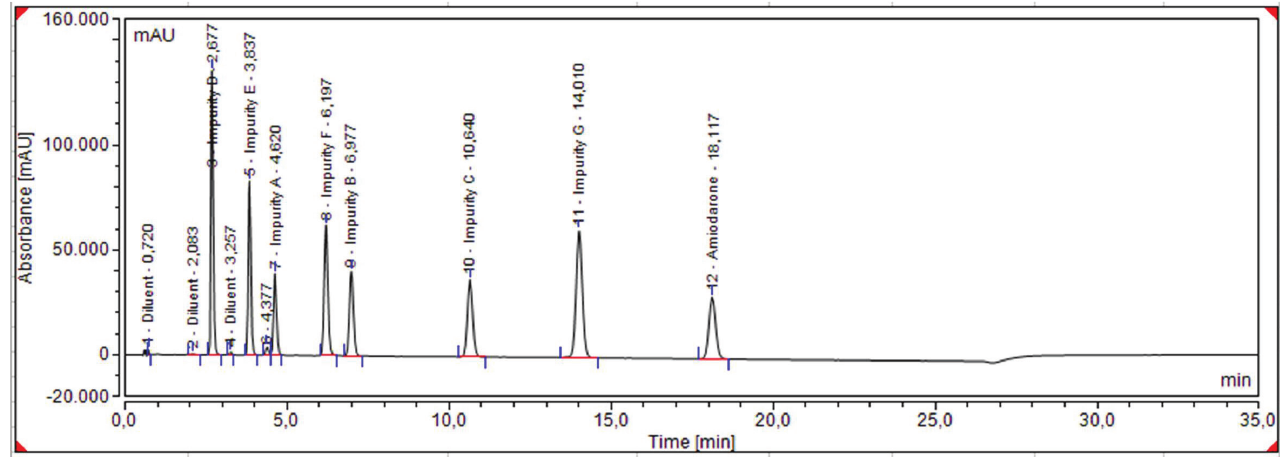
FIGURE 2 - Representative chromatogram of the impurity mixture standard.